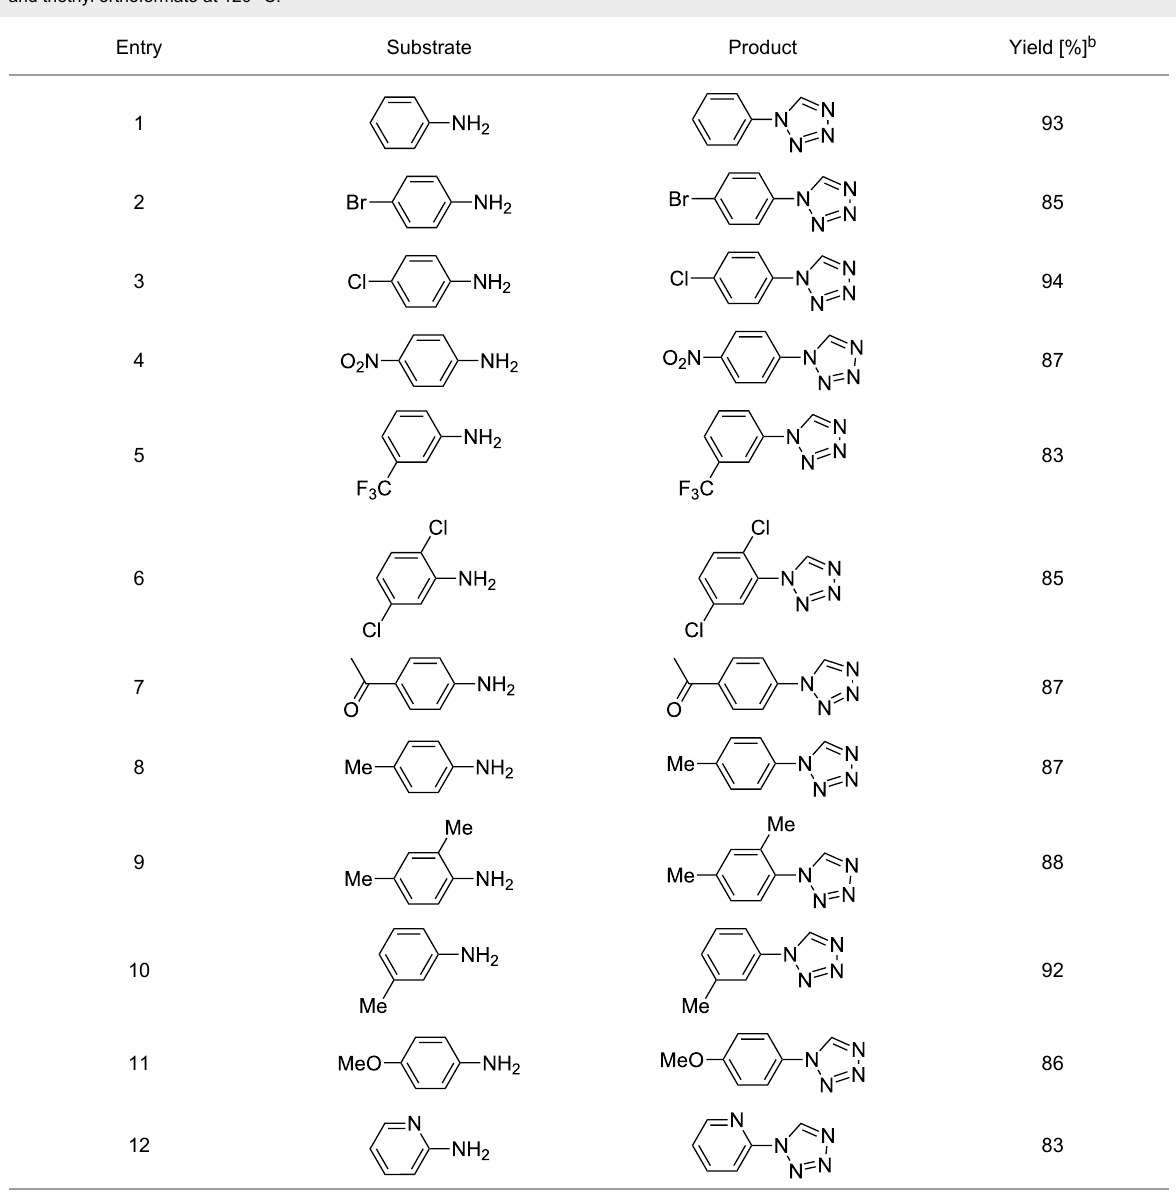
Table 2: Preparation of 1 - substituted 1 H - 1,2,3,4 - tetrazoles in the presence of Cu NPs/bentonite by reaction between sodium azide, primary amines and triethyl orthoformate at 120 °C.